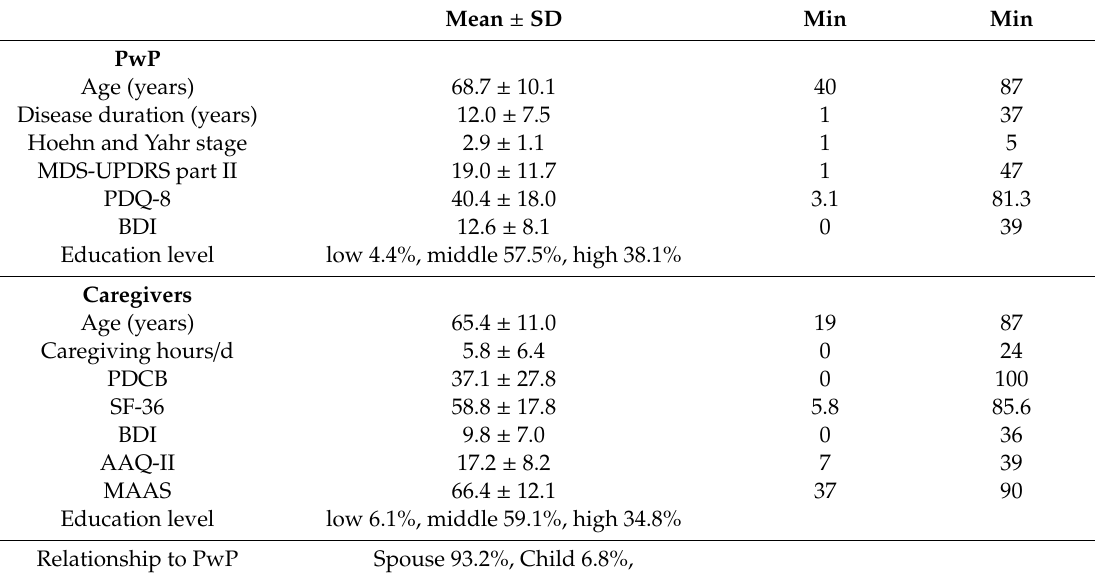
Table 1. Characteristics of people with Parkinson’s disease (PwP, n = 118, 45 females) and caregivers ( n = 118, 78 females).